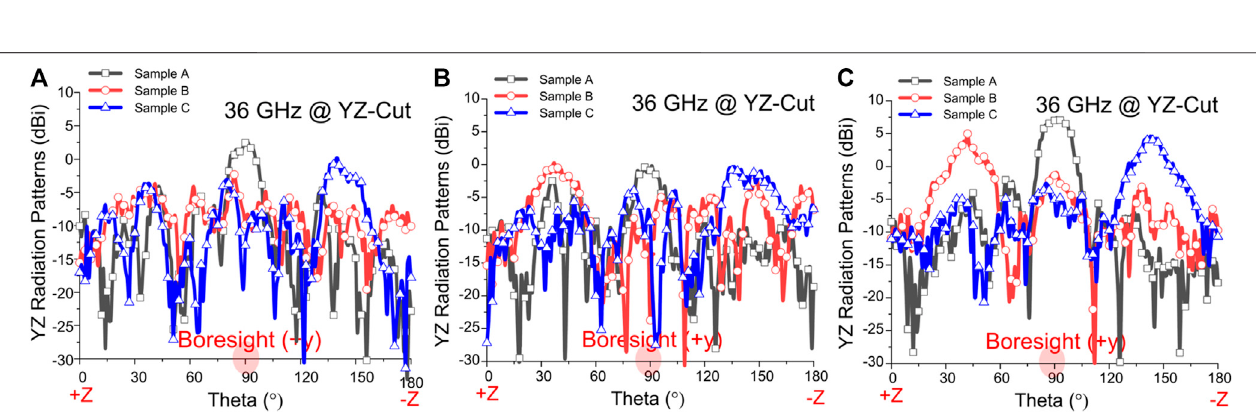
FIGURE9| Measuredradiationpatterns( E theta -polarization and36 GHz)ofthefabricatedarraysforthebeamsteeringtestinthehandsetmockup. (A) CPWTL. (B) GCPW TL without via fences. (C) GCPW TL with via fences.